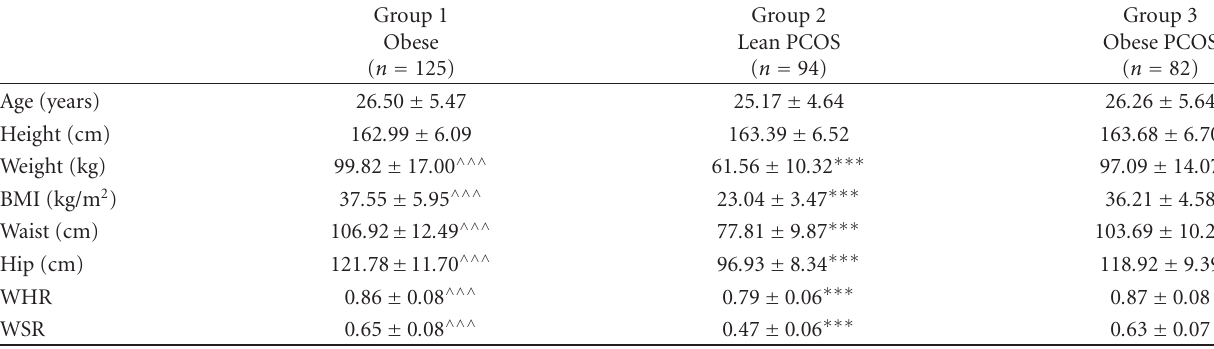
Table 1: Anthropometric characteristics of the groups.